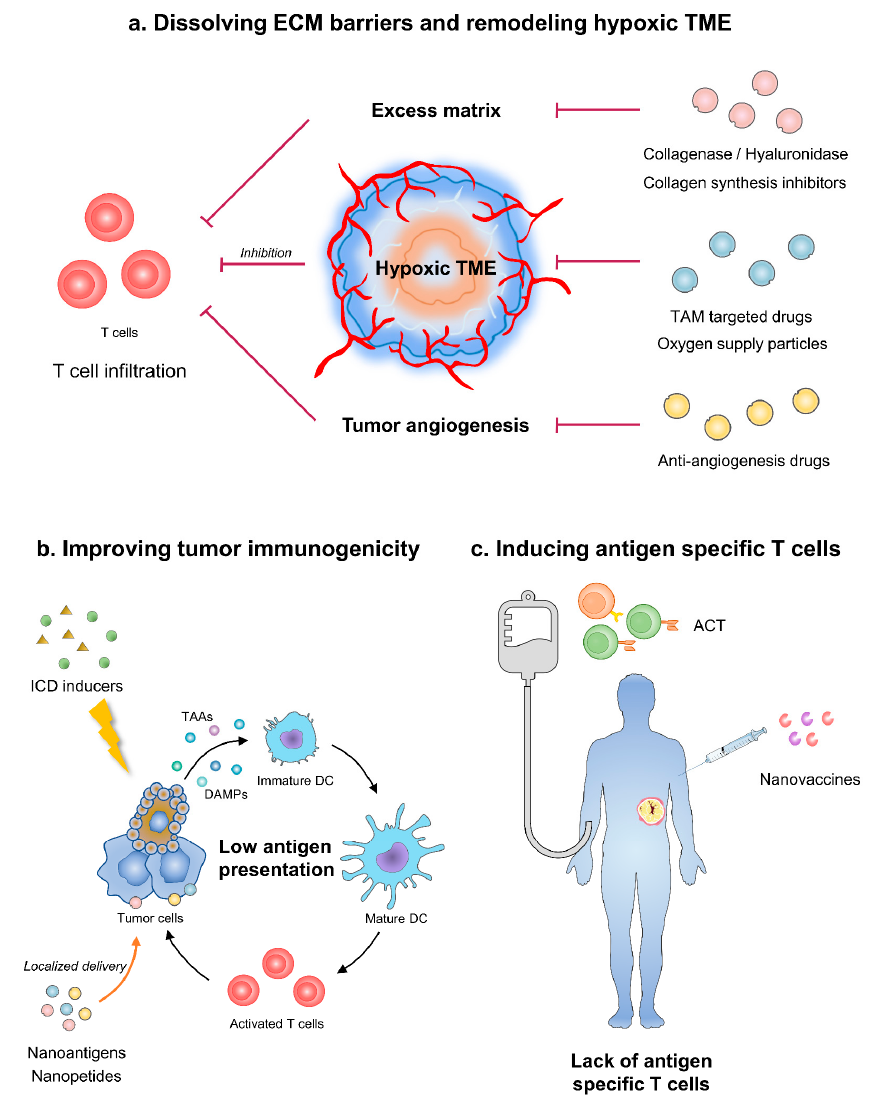
Figure 1. Strategies of nanoparticles in improving cancer immunotherapy. ( a ) Nanoparticles dissolv- ing ECM barriers and remodeling angiogenesis-caused hypoxia could improve T cell infiltration. ( b ) Nanomodified ICD inducers or vaccines can augment tumor immunogenicity. ( c ) ACT equipped with nanoparticles induce antigen specific T cells and relieve systematic immune dysfunction. ECM, extracellular matrix; TME, tumor microenvironment; TAM, tumor-associated macrophage; ICD, immunogenetic cell death; TAAs, tumor-associated antigens; DC, dendritic cells; ACT, adoptive cell